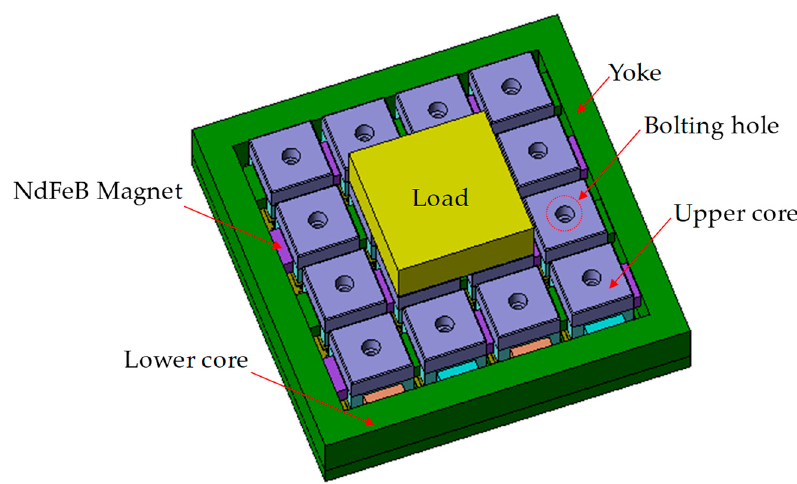
Figure 5. Basic structure of conventional H-EMMs. NdFeB, neodymium.